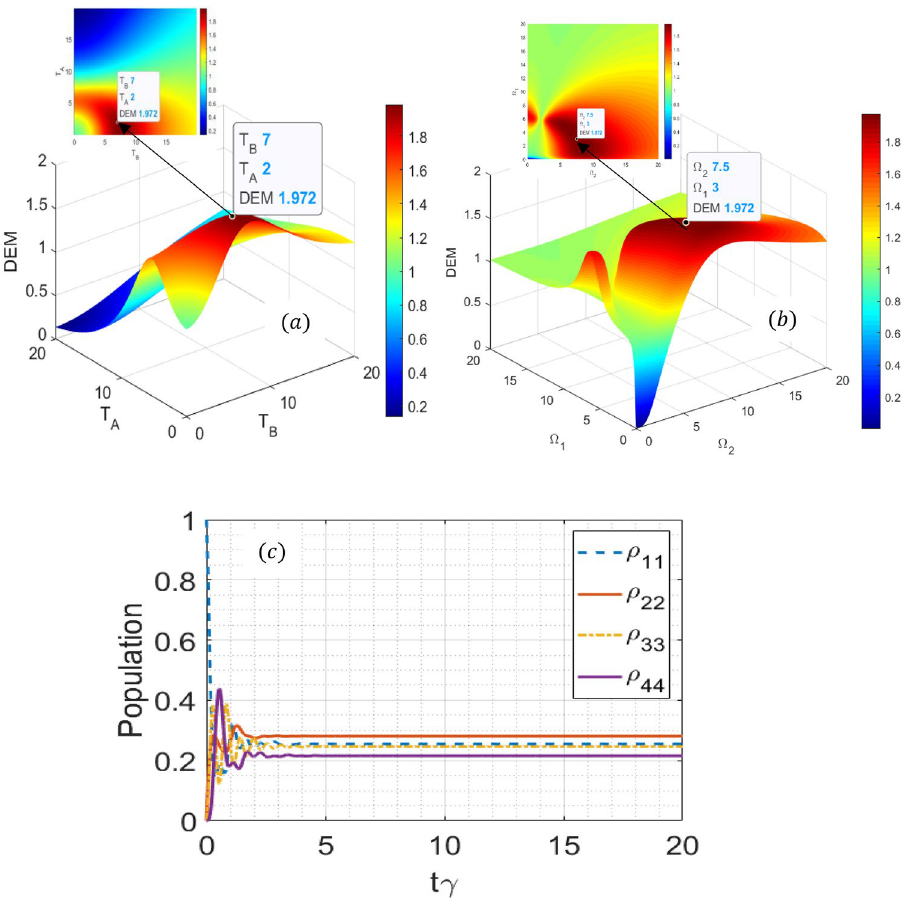
3 γ , and � 2 = 2 γ , and T B 7 γ . ( c ) Evolution of the population distribution a function of = = 3 γ , � 2 7.5 γ , T A 2 γ , and T B 7 γ . Other parameters are δ = = = =